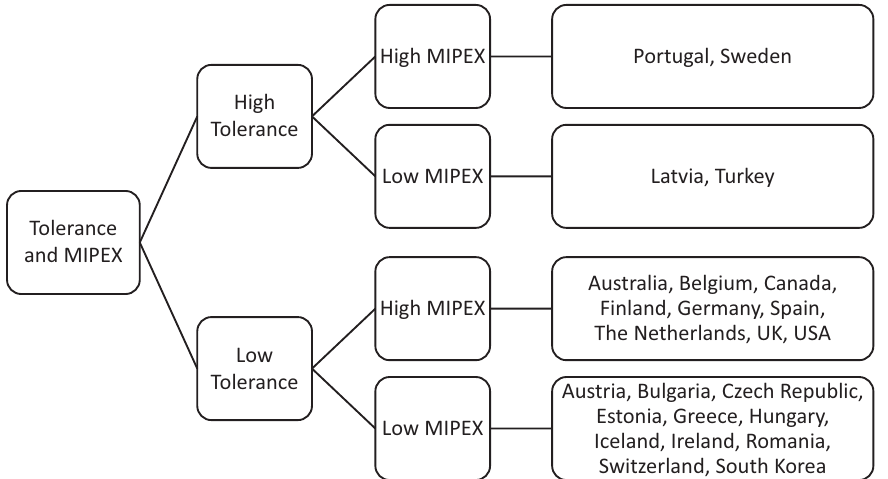
Figure 2. Four clusters of the press based on MIPEX and the role perception that journalists should promote tolerance and cultural